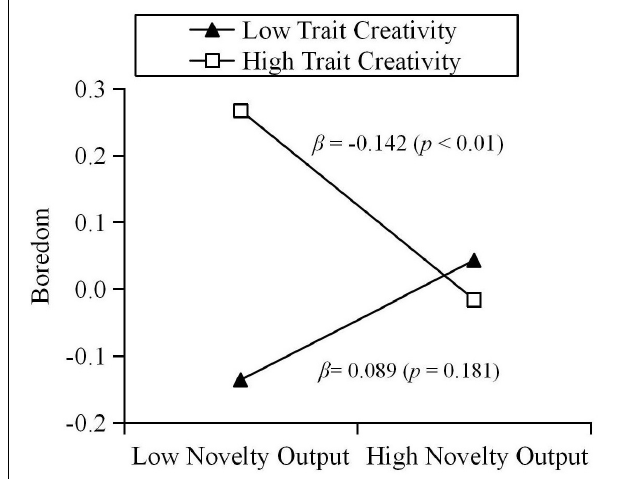
FIGURE 3 | Moderation effect of imagination on the relationship between novelty input and boredom.